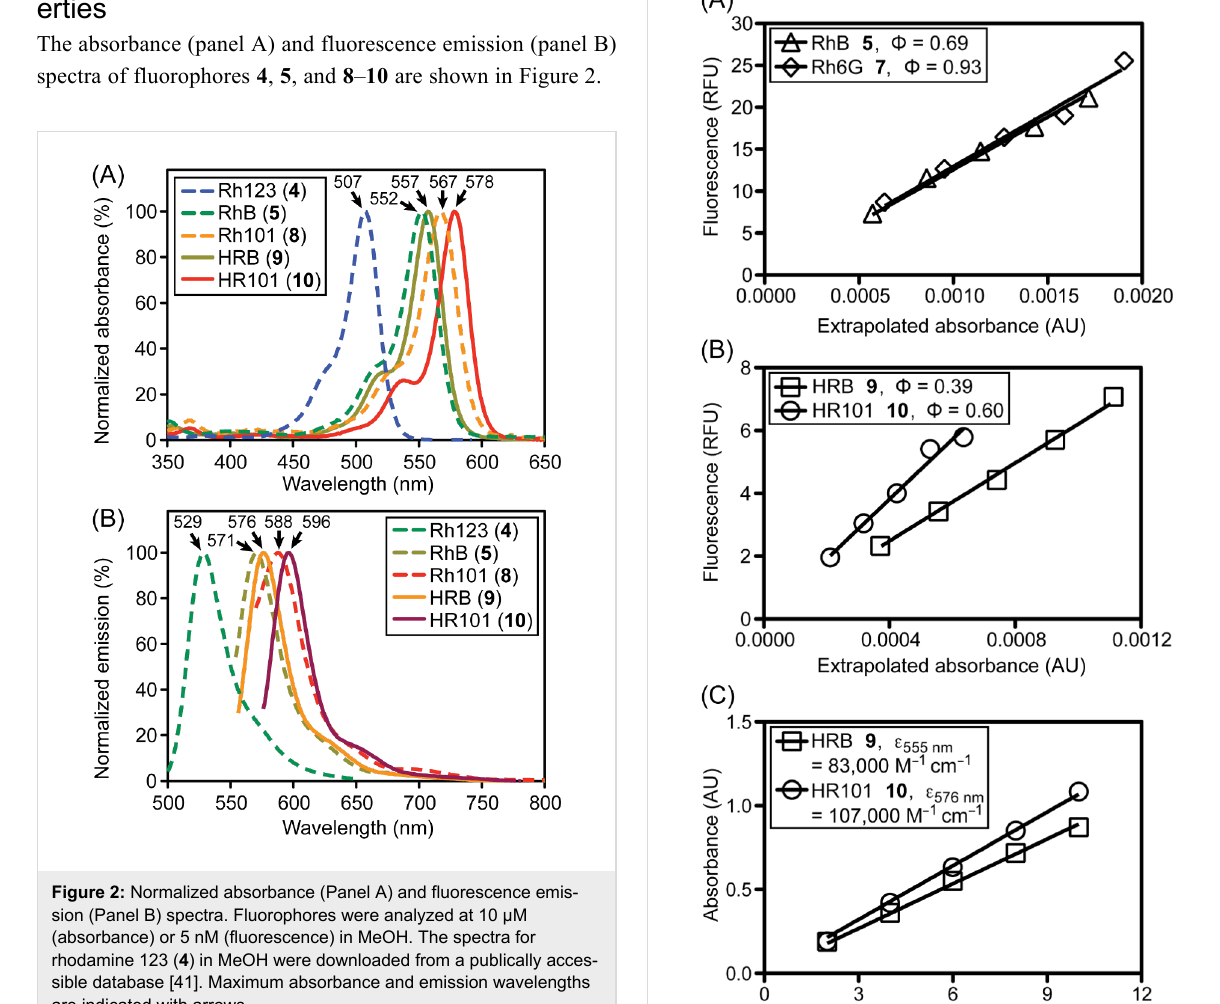
Spectroscopic studies revealed that HRB 9 and HR101 10 are not as bright as the carboxylate-containing parent